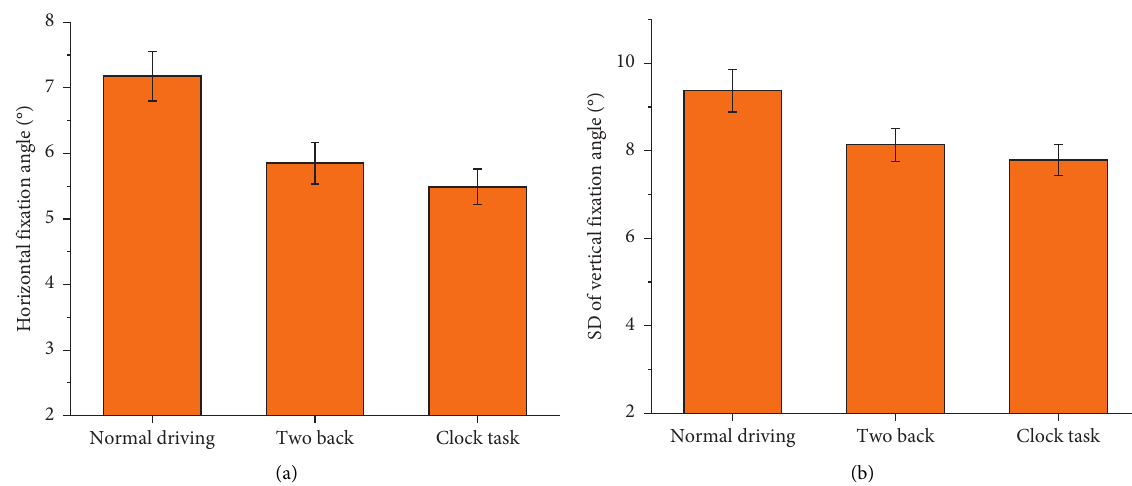
Figure 7: Main effect of the driving tasks on the (a) horizontal fixation angle and (b) vertical fixation